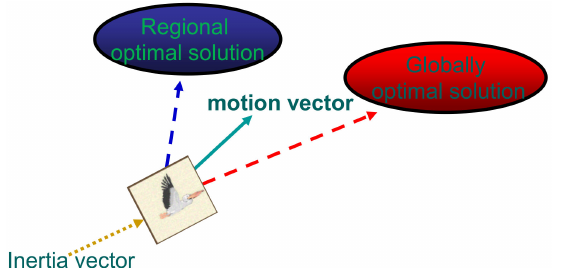
Figure 21. Schematic diagram of particle swarm